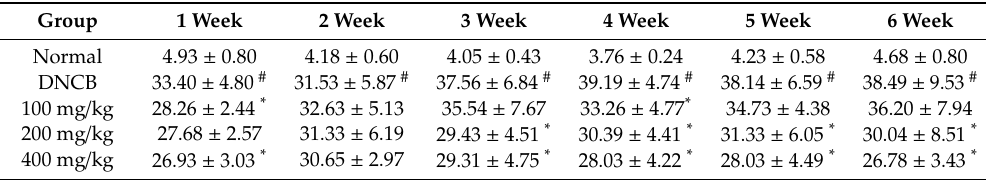
Table 2. The e ff ect of CQ on the TEWL in DNCB-induced BALB / c mice.